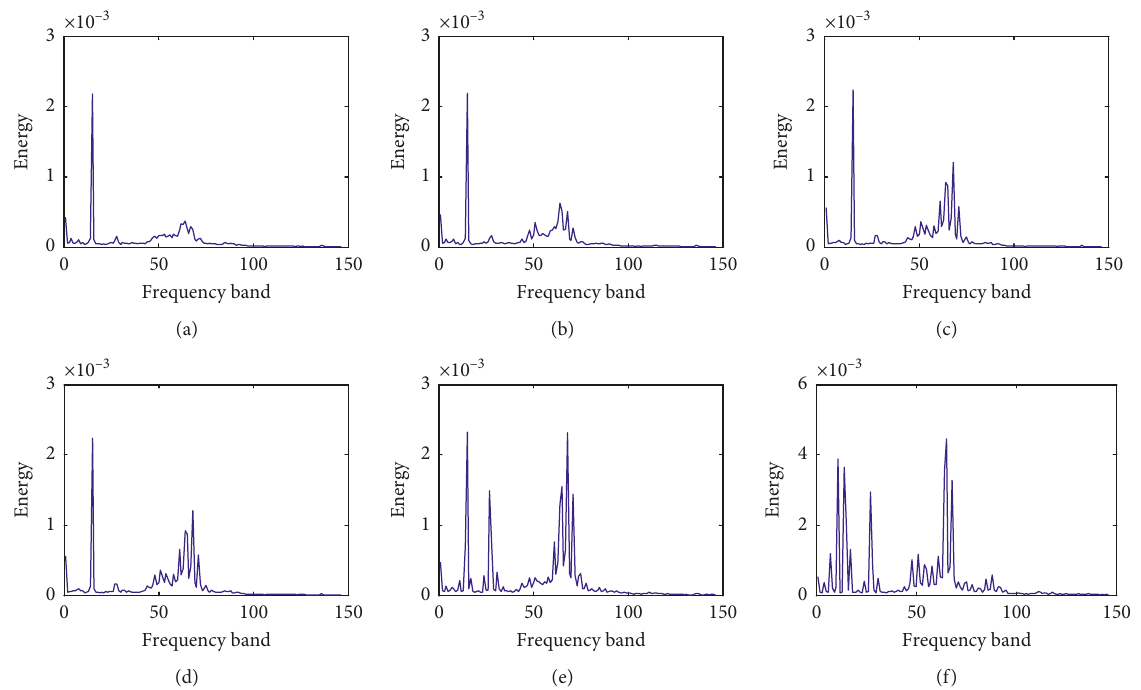
Figure 12: Frequency band energy spectrum of some samples. (a) The 500 th sample. (b) The 533 rd sample. (c) The 600 th sample. (d) The 702 nd sample. (e) The 823 rd sample. (f) The 950 th sample.